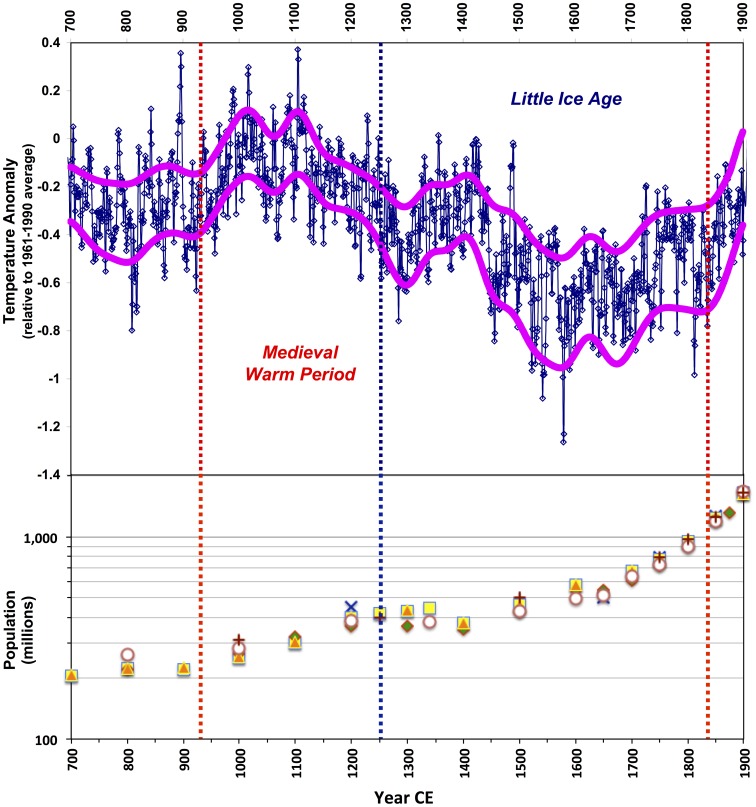
Northern Hemisphere temperature variation, 700 AD – 1900 AD, juxtaposed with historical population estimates.Historical climate proxy data are from the supplementary materials in ref. [35]. Historical population data as in Fig. 1.